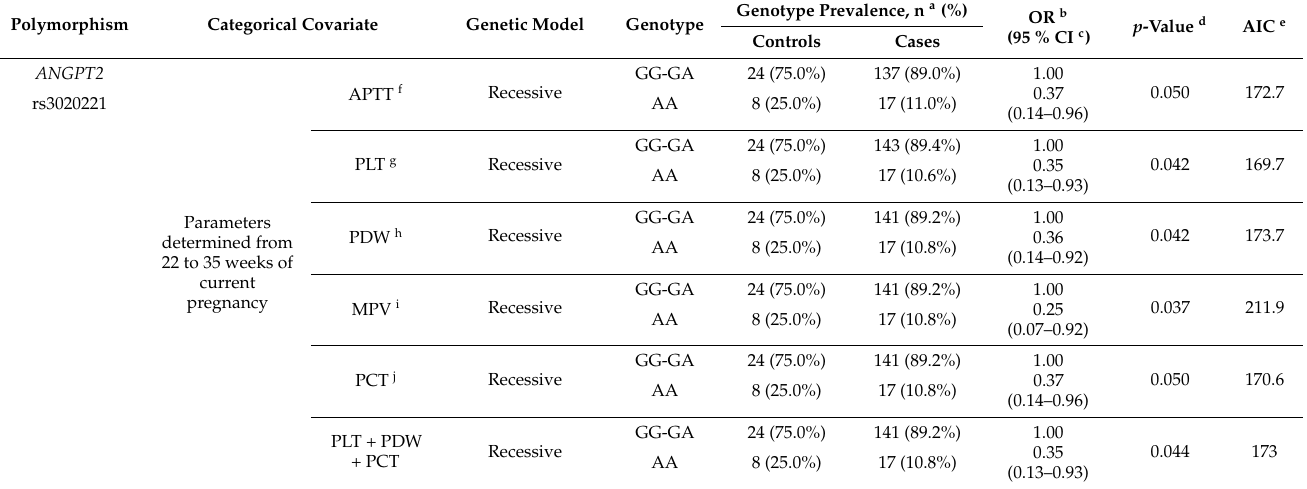
Table 3. Association of ANGPT2 , TLR2 and TLR9 SNPs with PTL, corrected for APTT and PLT parameters and the occurrence of pregnancy